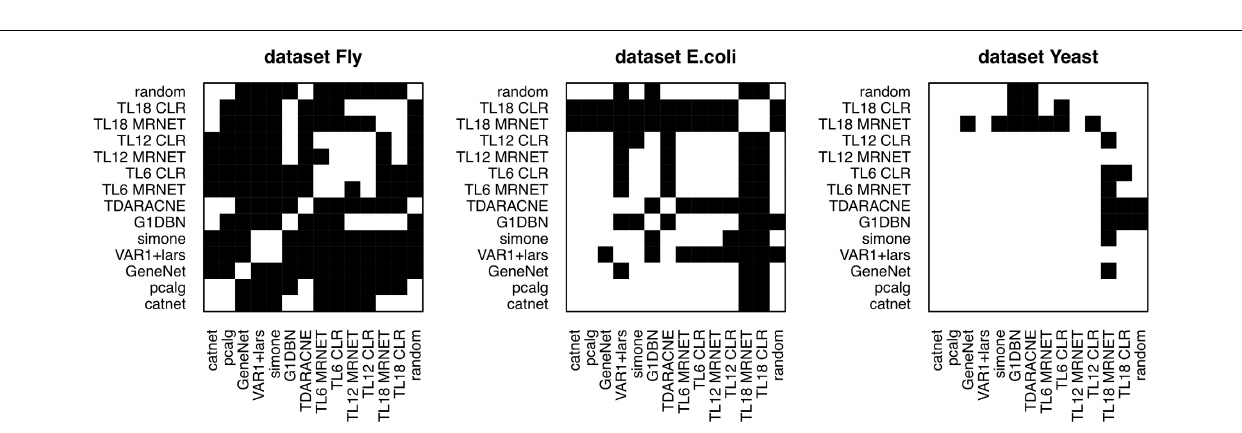
FIGURE 3 | Existence (black) or not (white) of a significant difference between the algorithms performance.